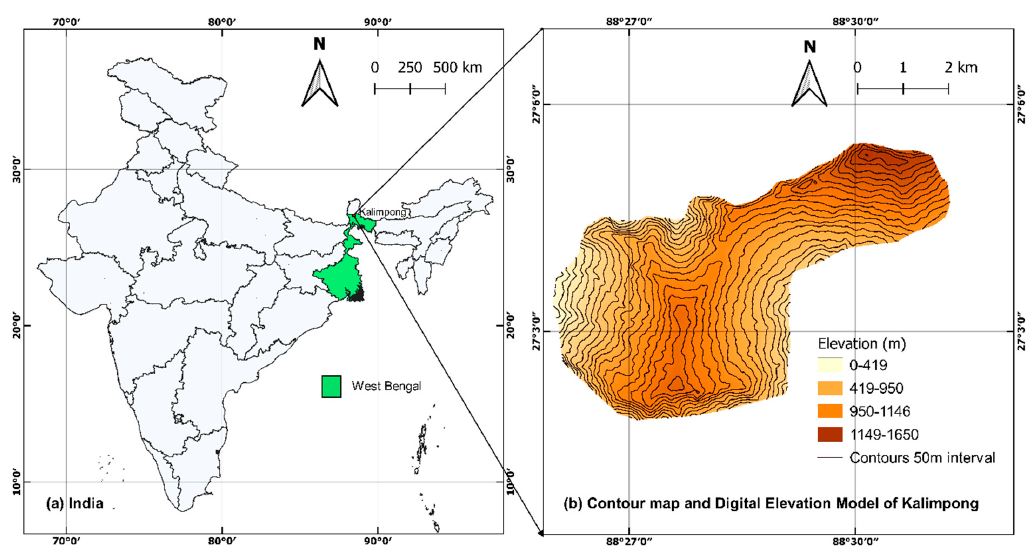
Figure 1. Location details of study area.